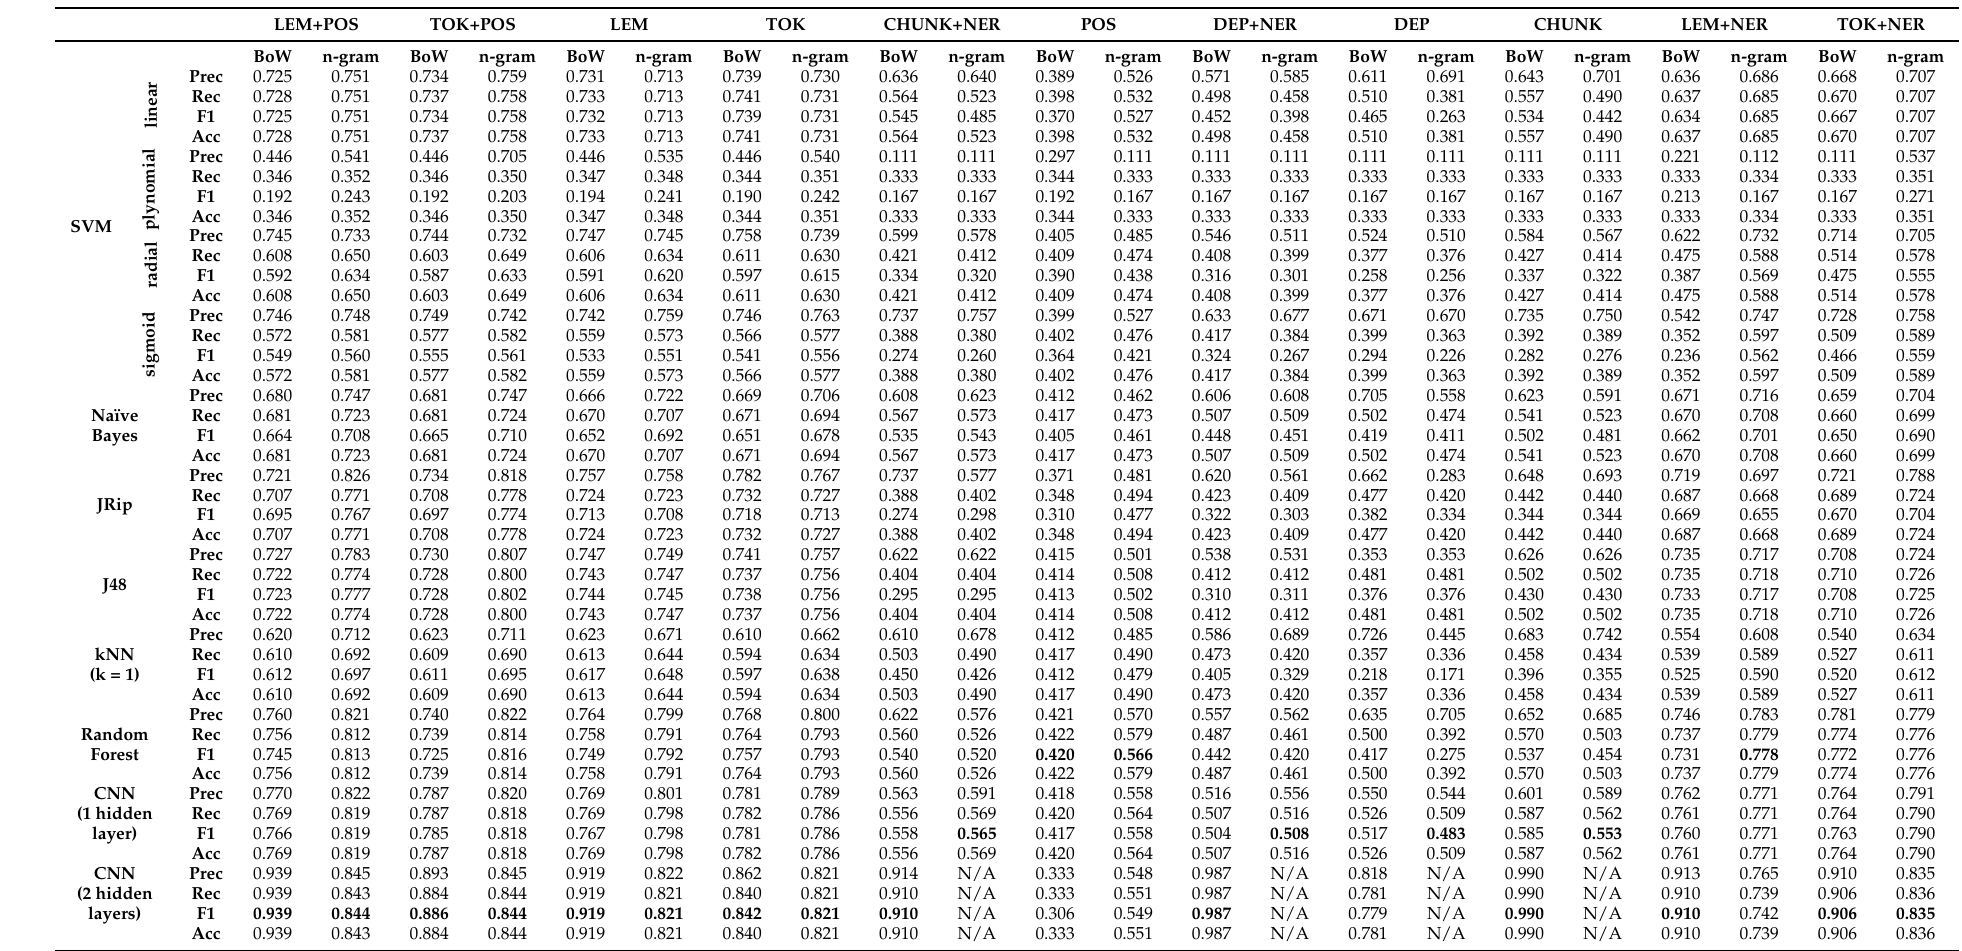
Table 10. Results of all applied classifiers (scores averaged for primary , sesquiary , and secondary prediction, calculated separately; best classifier for each dataset in bold type font ; best dataset generalization for each